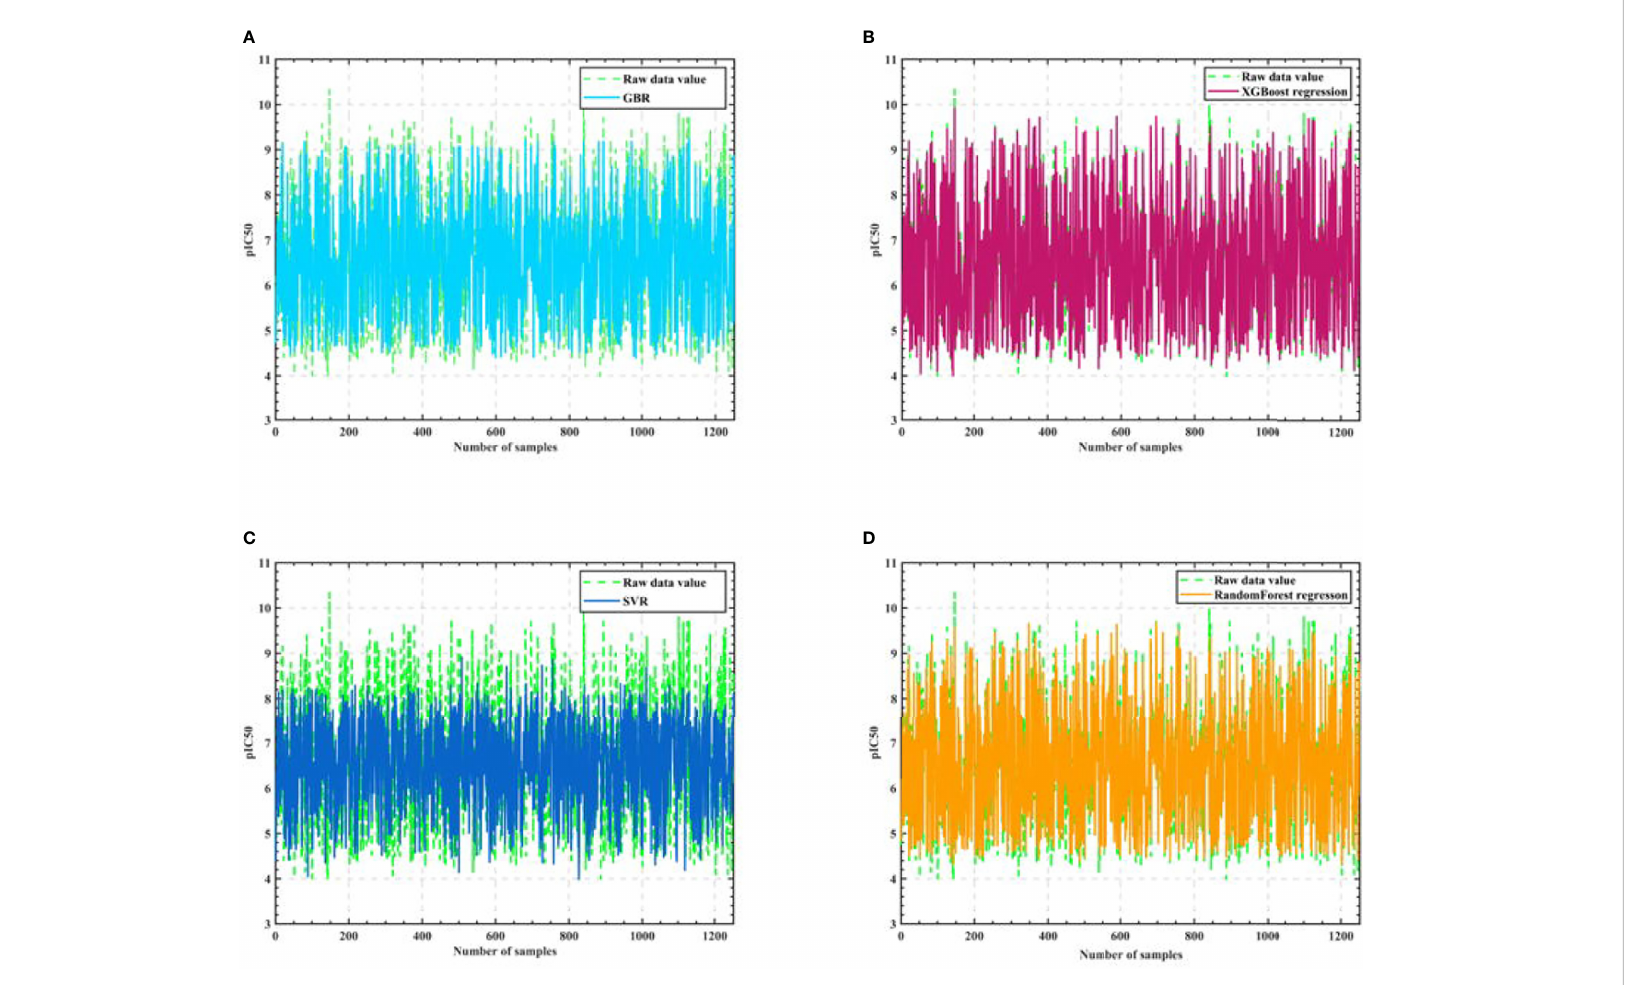
FIGURE 3 Algorithm model training process. (A) GBR (B) XGBoost regression (C) SVR (D) Random Forest